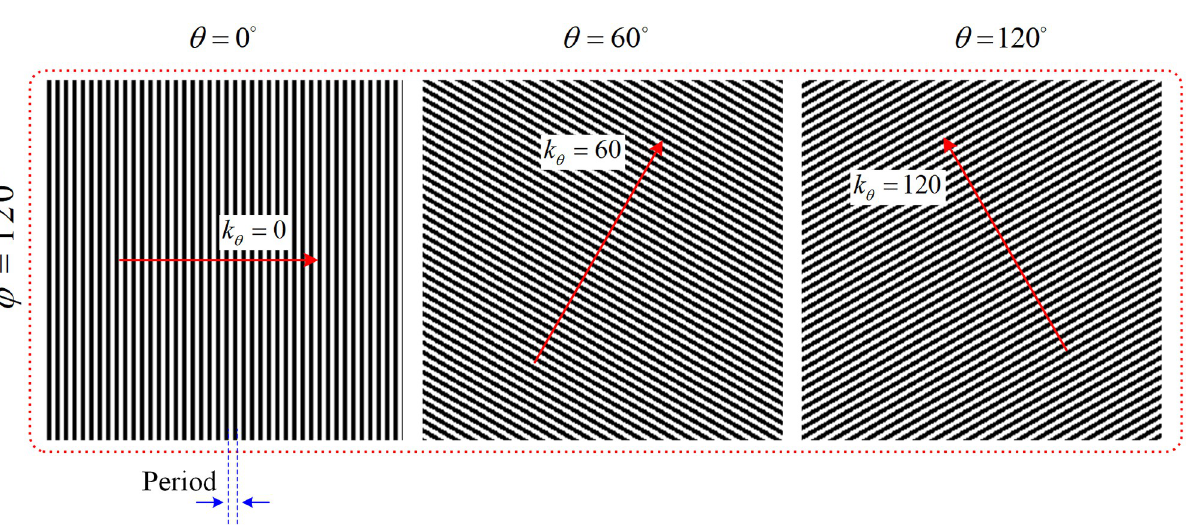
Fig 1. Exemplary illumination patterns created in 3 different orientations θ 1 = 0˚, θ 2 = 120˚, θ 3 = 60˚ with the same phase value of φ = 120˚.